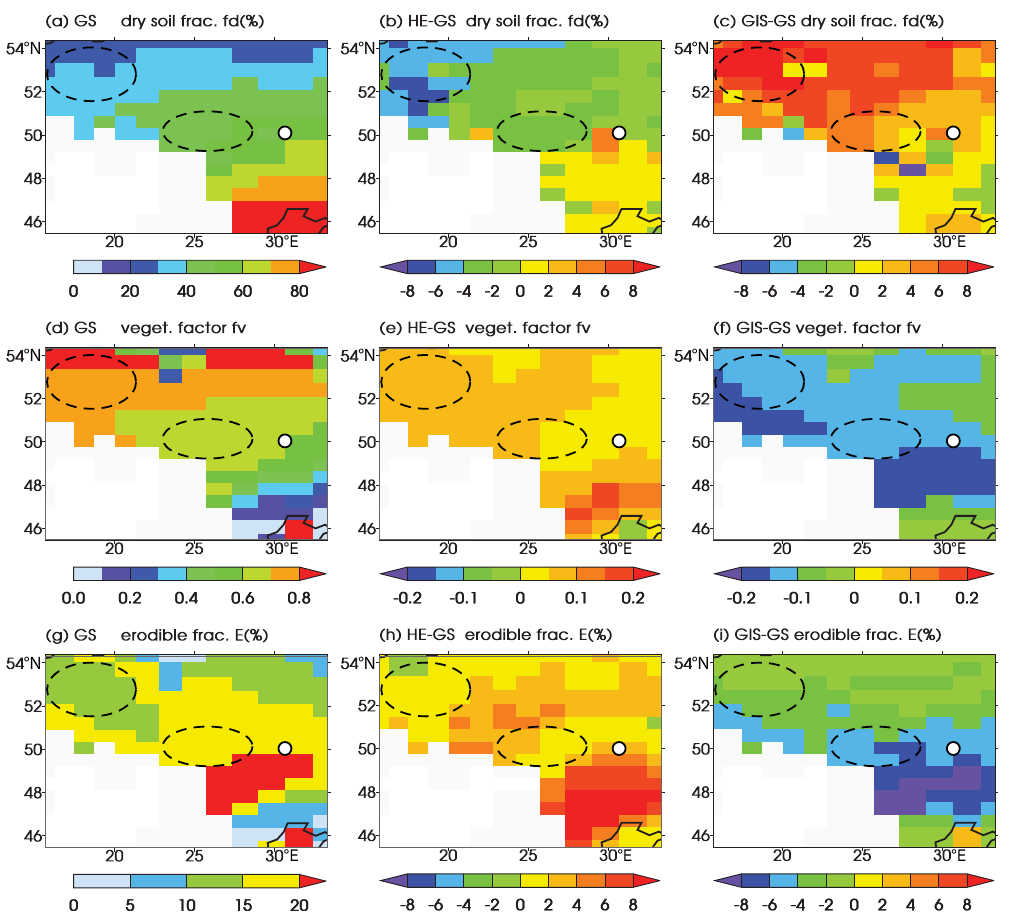
Fig. 8. Averages over the dust emission period (February to June) for dry soil fraction F d , vegetation factor F v , and erodible soil fraction E in the GS state (left column), and anomalies HE-GS (center column) and GIS-GS (right column). Masked in white are the Carpathians (altitudes exceeding 500m) and the lowlands inside the mountain arch (cf. Sect.